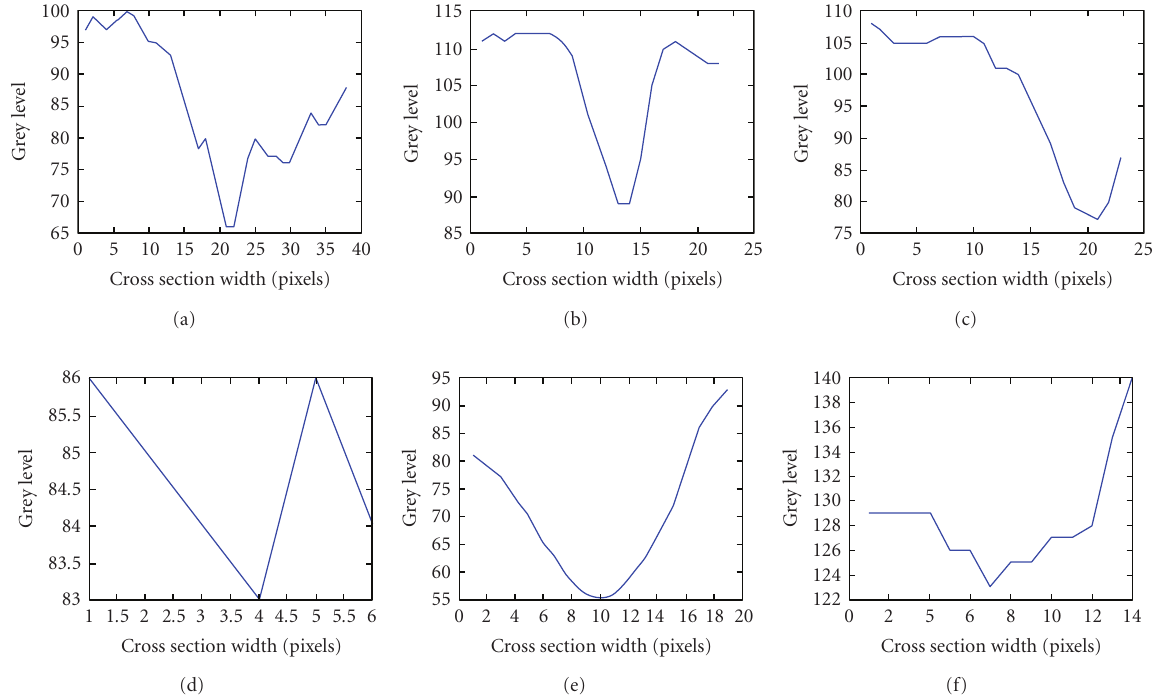
Figure 6: (a–f) Indicative cross section profiles encountered in 1D cross the line of CL: (a) mixed pattern that can be modelled both as double peaked and single peaked GS-MF for di ff erent peak values and spreads, (b,e) clear single peaked patterns, (c,f) single sided patterns modelling wall transition, (d) very shallow and narrow width vessel for pixel width.